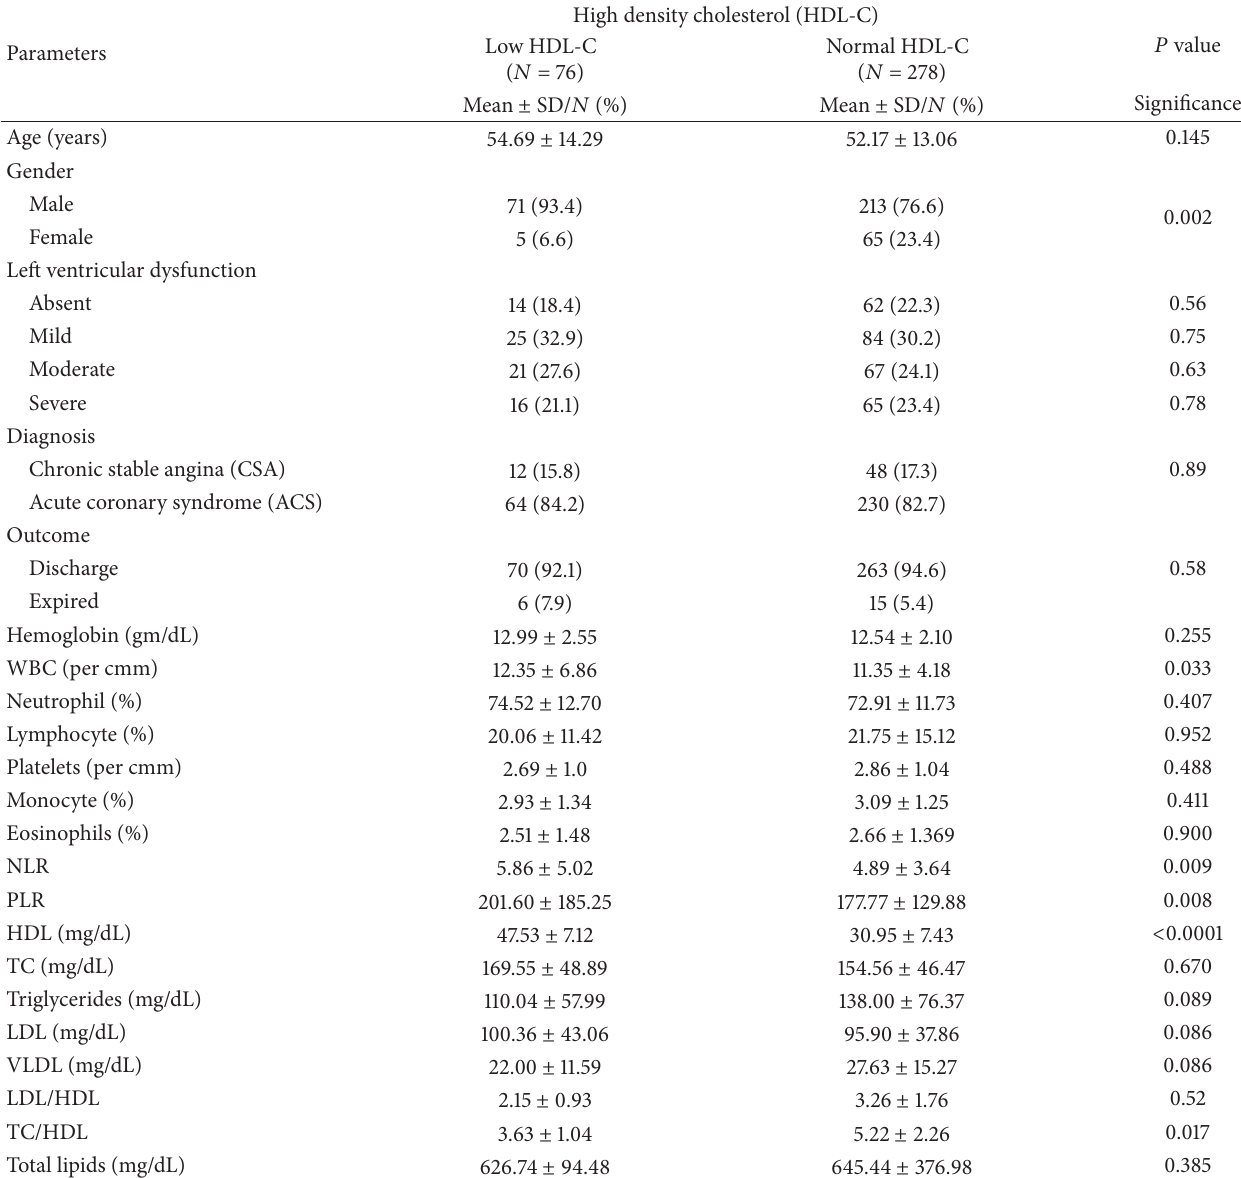
Table 2: Demographic, clinical, and laboratory characteristics of the population according to HDL-C